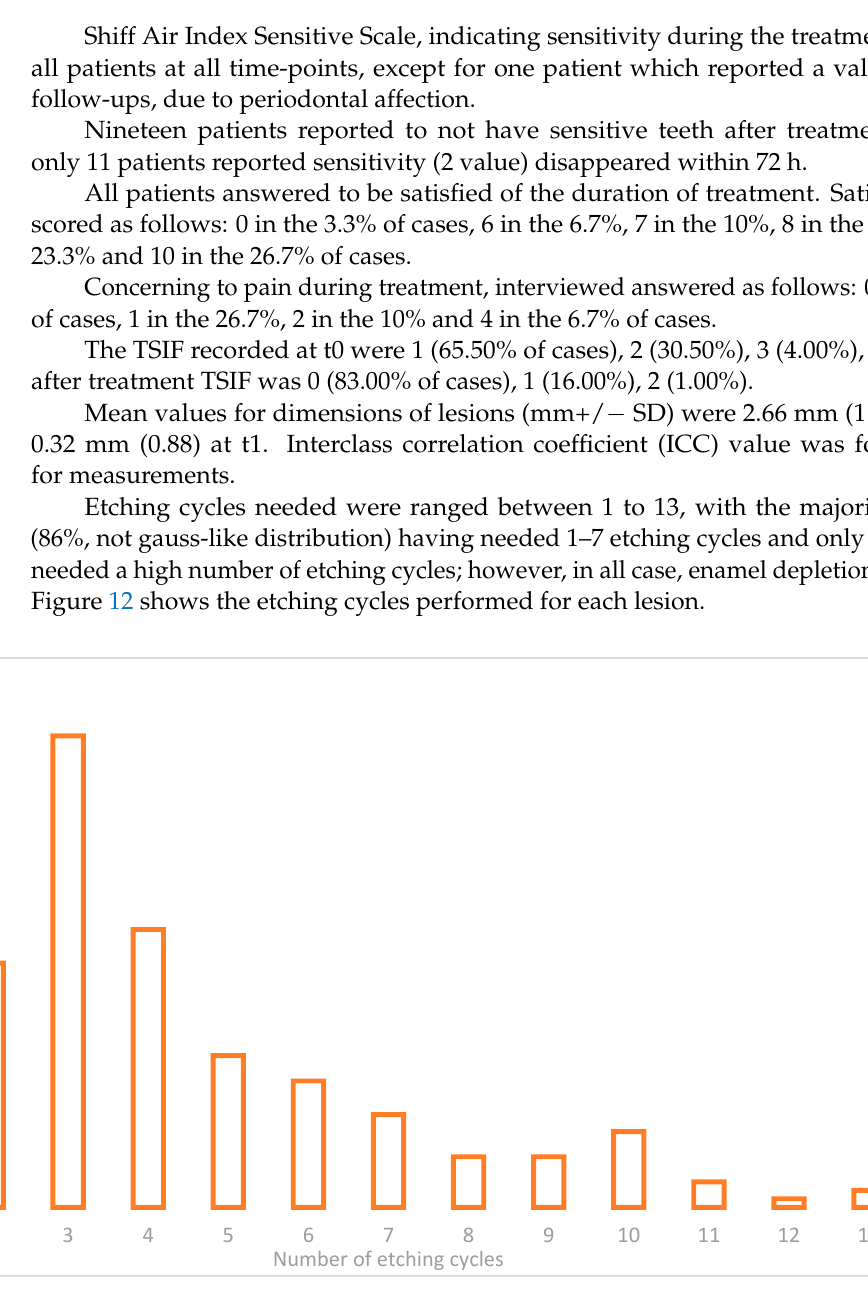
cycles were correlated to sensitive teeth at 72